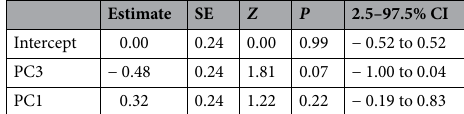
Table 4. Averaged model parameter estimates for the top three ranked linear models in Table 3.